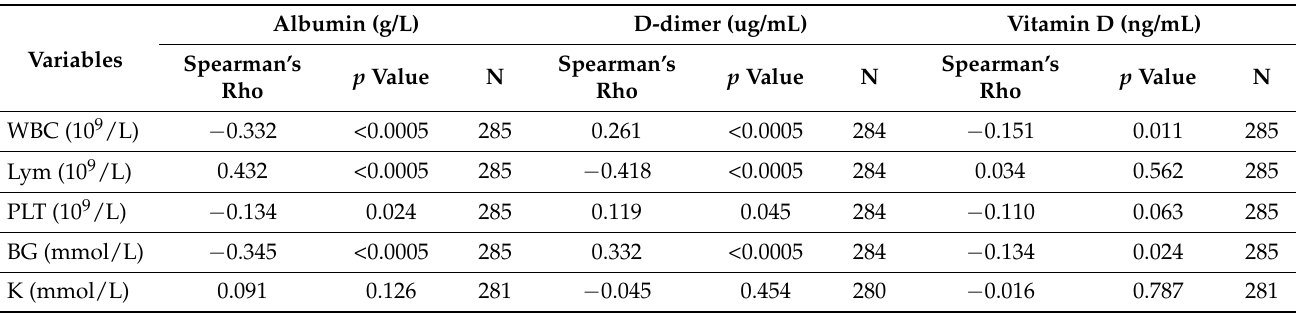
Table 3. Correlations of serum albumin, D-dimer, and vitamin D with other biochemical parameters in patients with COVID-19. The serum values of the biochemical parameters were obtained from blood samples immediately after admission to the hospital for treatment (n = 288). Statistical significance was examined using the Spearman correlation coefficient. Values of p < 0.05 were considered statistically